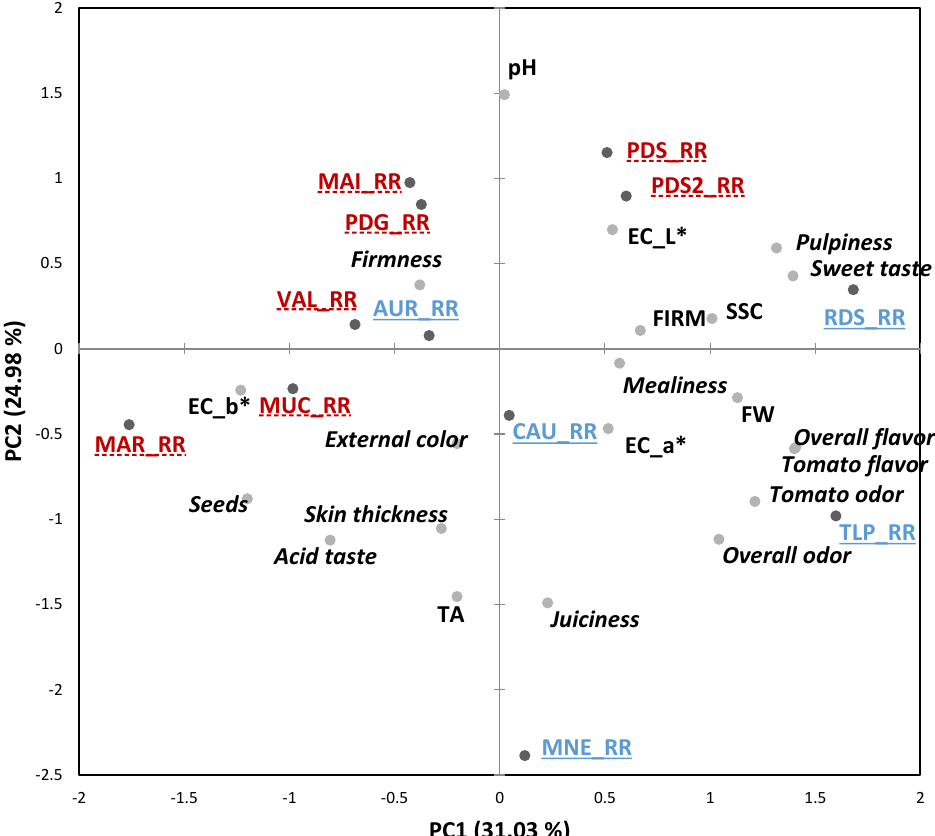
Figure 4. Principal component analysis (PCA) Bi-plot of the sensory and physicochemical parameters of the 12 tomato genotypes grown in Italy and evaluated at red ripe stage (RR). Sensory descriptors are indicated in italics . Modern varieties are in blue, underlined with solid lines; Traditional varieties are in red, underlined with dashed lines. FW = fruit weight, FIRM = firmness, SSC = soluble solids content, TA = titratable acidity. Product codes are listed in Table 1.